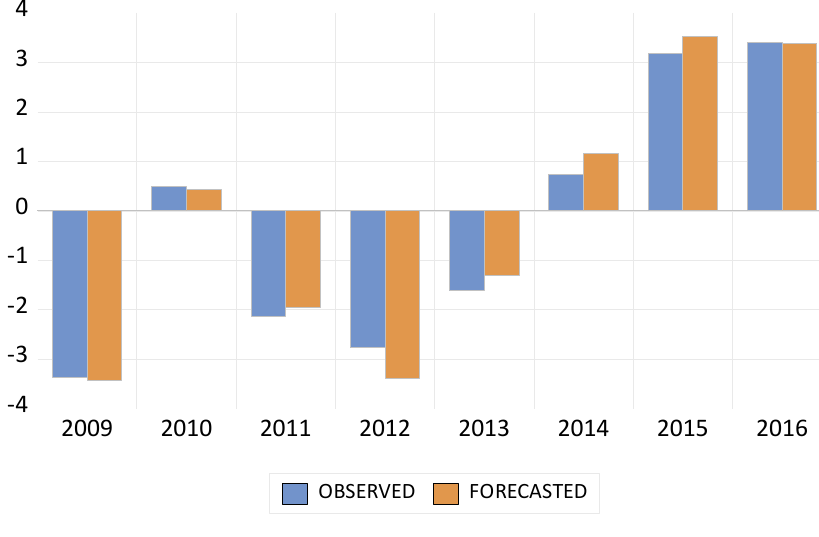
Figure 5 : Observed and SCM forecasted Galician GDP growth